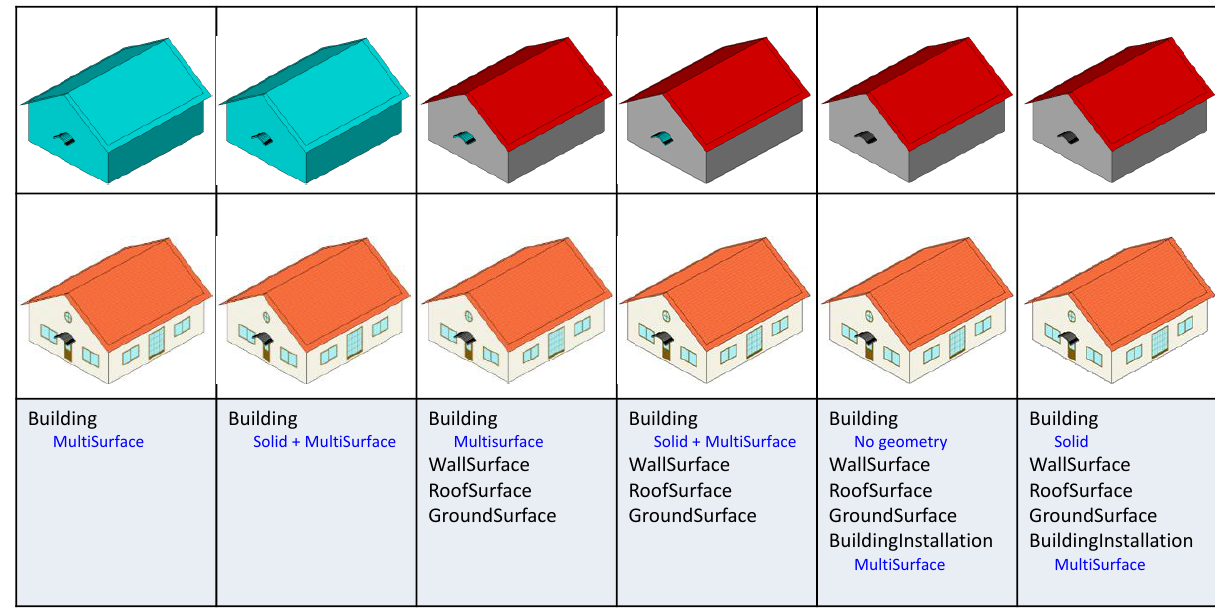
Figure 4: Legal variants of a CityGML LoD2